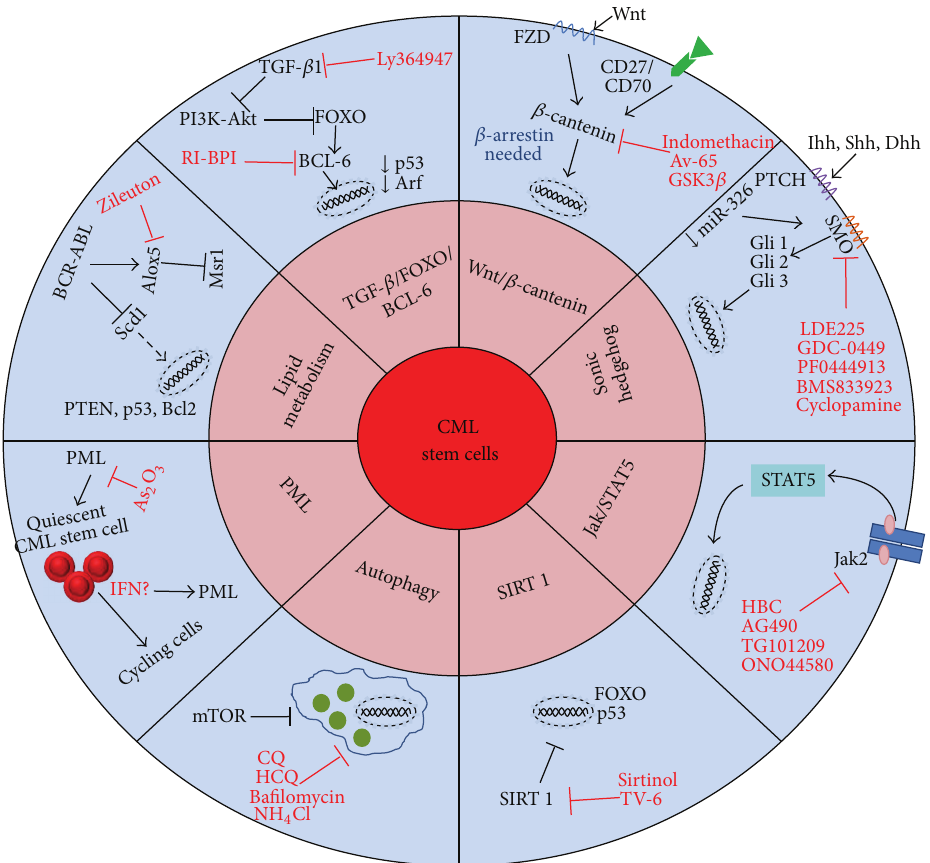
Figure 5: Alternative signaling pathways for overcoming resistance of CML Stem Cells against tyrosine kinase inhibitors. Sonic hedgehog (Shh), Indian hedgehog (Ihh), Desert hedgehog (Dhh), Smoothened (Smo), STAT5 (signal transducer and activator of transcription), retroinverso BCL6 peptide inhibitor (RI-BPI), chloroquine (CQ), hydroxychloroquine (HCQ), Sirtuin 1 (SIRT1), tenovin-6 (TV-6), Arachidonate 5-lipoxygenase ( Alox5 ), stearoyl-CoA desaturase 1 (Scd1), promyelocytic leukemia protein (PML), arsenic trioxide (As 2 O 3 ), and Interferon alpha